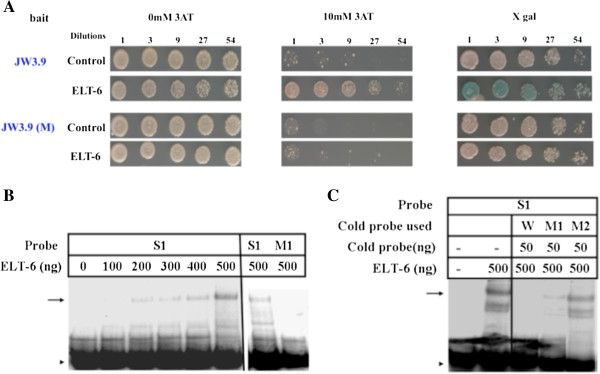
ELT-6 interacts with pJW3.9 through a GATA binding site. A) Yeast strains containing HIS3 and lacZ reporters transformed with empty vector (Control) or ELT-6::GAL4AD plasmids (ELT-6) were diluted and replica plated to control (left), 10 mM 3aminotriazole (3AT, middle), and XGal (right) plates. Reporters had inserts of either JW3.9 (top) or JW3.9 in which GATA binding site S1 was mutated from TGATAA to GGTACC (‘Mut’ bottom). Mutation of the GATA site abolishes the interaction with ELT-6 based on lack of growth on 3AT and lack of blue color on XGal.; B) Increasing concentrations of ELT-6 interact with a 40 bp fragment around GATA site S1 (lanes 2-6). Mutation of the GATA site S1 from TGATAA to GGTACC (M1) abolishes interaction with ELT-6 (lane 8); C) 50 ng of cold wild type site S1 (W) can compete effectively for binding of ELT-6 to S1 (compare lanes 2 and 3). Mutation of GATA site S1 (M1) reduces but does not abolish the ability to compete (lane 4). Mutation of both site S1 and a second GATA site on the oligonucleotide (M2) drastically reduces the ability of the oligonucleotide to compete for ELT-6 binding (lane 5).